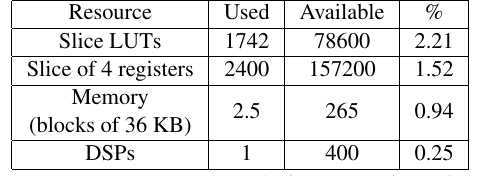
Resources usage of the resampling design in Xilinx/Zynq-7030 FPGA.